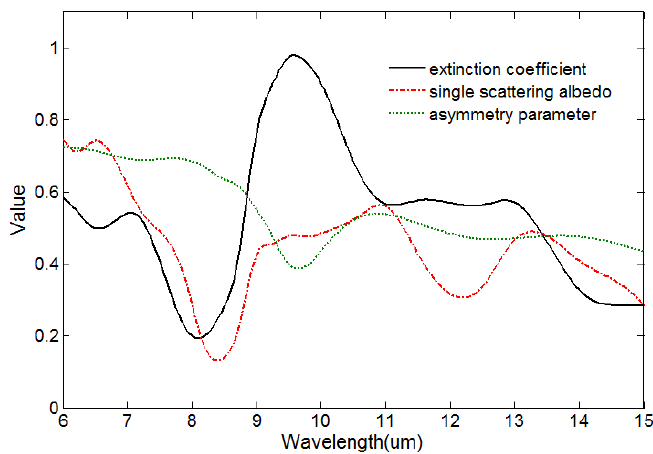
Figure 1. The normalized extinction coefficient, single scattering albedo and asymmetry parameter of dust aerosol at 6–15 μm wavelengths.